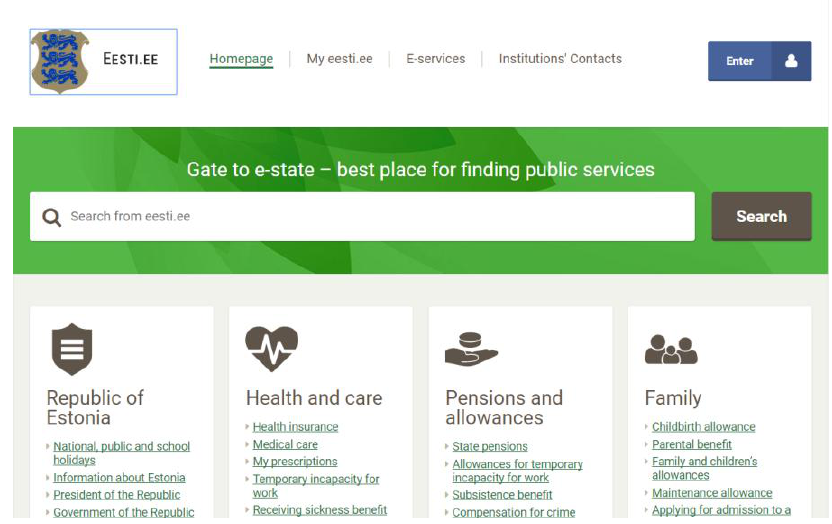
Figure 9. Screenshot of Estonian State Portal containing the most popular sections of the web